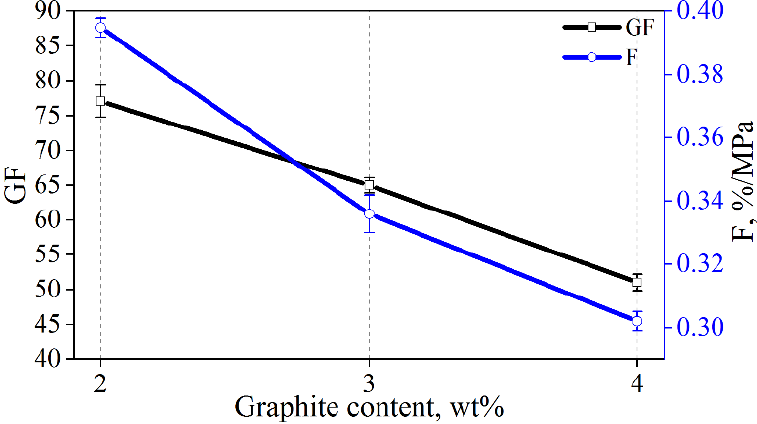
Figure 10. Gauge factor (GF) and stress sensitivity (F) of composites with exfoliated graphite. Table 3. Comparison of sensitivity of cement composites with conductive additives.